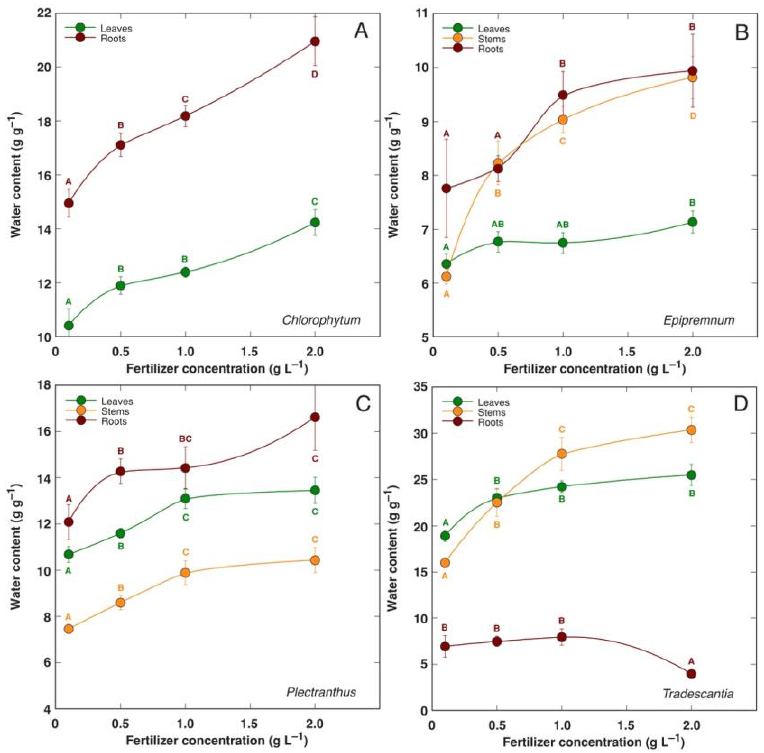
Figure 1. Changes in water content of different parts of hydroponically cultivated Chlorophytum comosum ( A ), Epipremnum aureum ( B ), Plectranthus fruticosus ( C ), and Tradescantia pallida ( D ) plants with increasing fertilizer concentration. Different letters indicate statistically significant differences for a particular plant part ( p < 0.05). Modified from Ievinsh et al., 2021 [43].